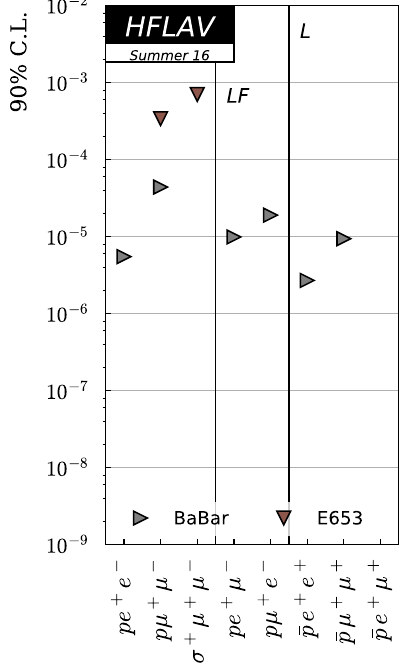
Fig. 219 Upper limits at 90% C.L. for Λ + c decays. Shown are flavor- changing neutral current decays, lepton-flavor-changing (LF) decays, and lepton-number-changing (L)